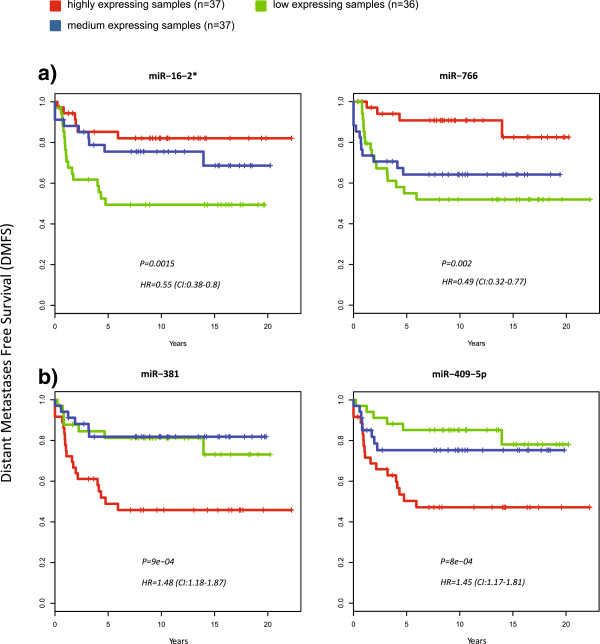
Kaplan-Meier curves of the four miRNAs showing strongest association with distant-metastases free survival (DMFS) in triple-negative tumours. Patients are stratified into three groups according to the miRNA expression level tertiles. (a) "favourable" miRNAs, whose expression is associated with better prognosis (HR < 1) (b) "unfavourable" miRNAs, whose expression is associated with poorer prognosis (HR < 1). The hazard ratio indicates the risk change if miRNA expression rises by one standard deviation.